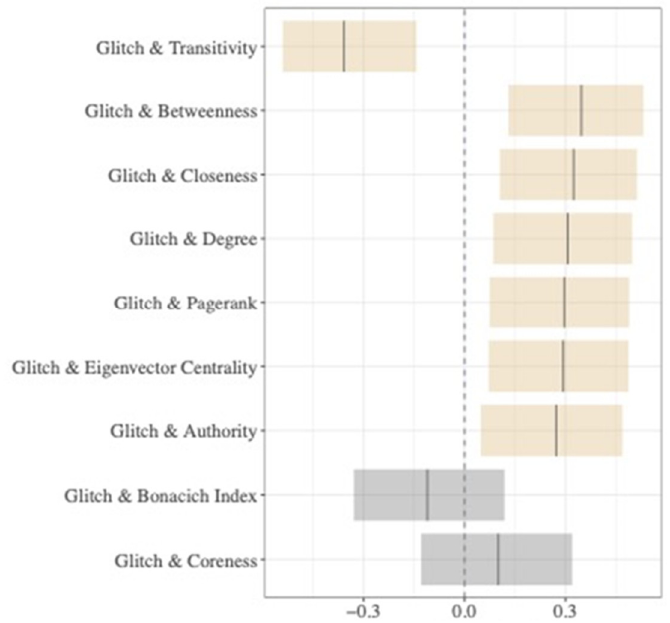
Figure A2. Correlations between glitches and centrality measures. In orange, the values for which a p -value is less than 0.05 (see Table A2 for the p -values). Table A2. Pearson